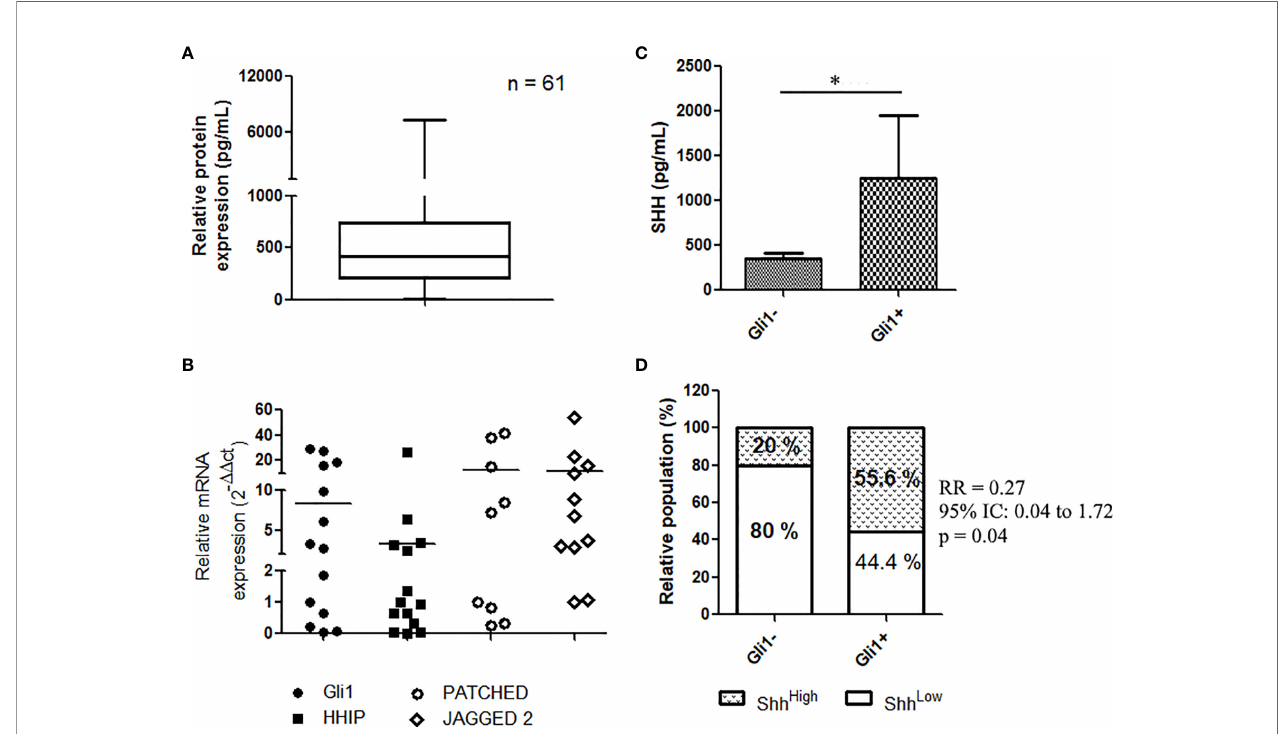
FIGURE 1 | Shh signaling expression and activation in EGFR-mutated NSCLC patients: (A) Shh concentration in plasma from patients at diagnostic ( n = 61) as assessed by ELISA assays. (B) mRNA expression of Gli1 target genes in NSCLC; data are expressed as mean ± SEM of 14 patients analyzed in duplicate. (C) Representative, IHC of Gli1 in NSCLC ( n = 14). (C, D) Expression of Shh in plasma from patients (14) according to Gli1 expression. * p <